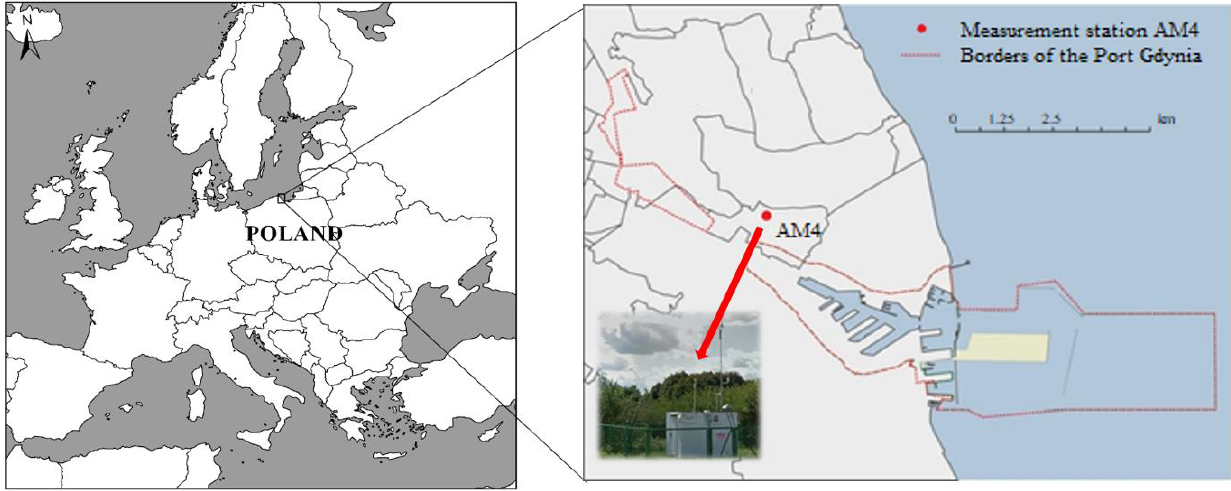
Figure 1. Location of the measurement point in Gdynia Pogórze and the boundaries of the port in Gdynia (www.dziennikbaltycki.pl, accessed on 15 January 2022 )